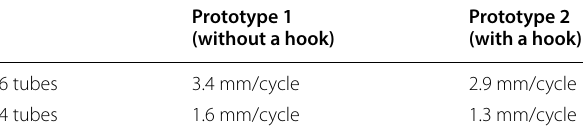
Table 2 Locomotion speed in a straight pipe